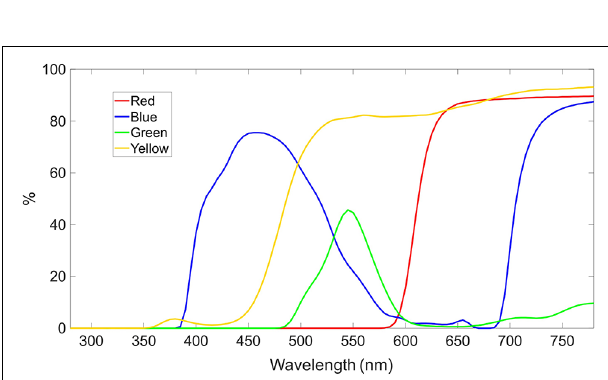
FIGURE 2 | Spectral transmission of color-tinted lenses in percentage. The yellow- and red-tinted lens are high-pass filter with cut-off at ca. 480 nm and 610 nm, respectively. The blue- and green-tinted lens transmits the spectral curve of an inverted U-shape with peak at ca. 460 nm and 550 nm,